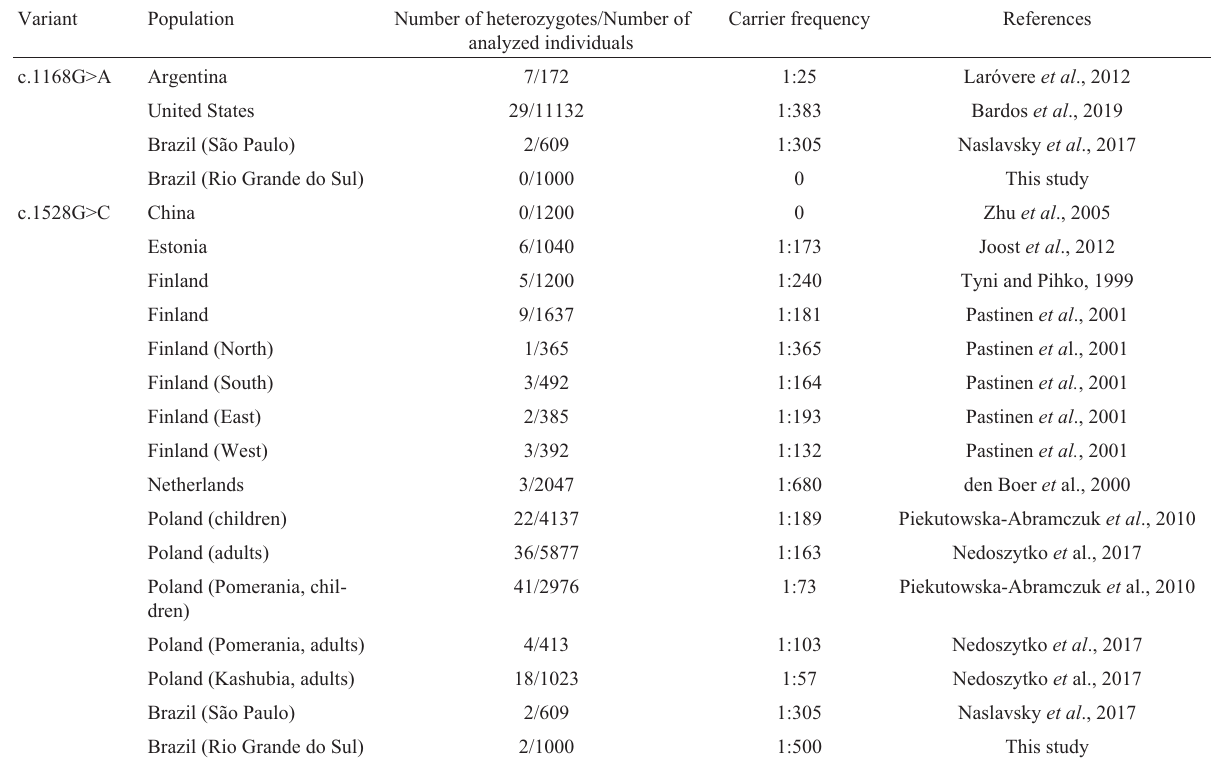
Table 3 - Carrier frequency of the c.1168G>A ( ASS1 ) and c.1528G>C ( HADHA ) variants in different populations.